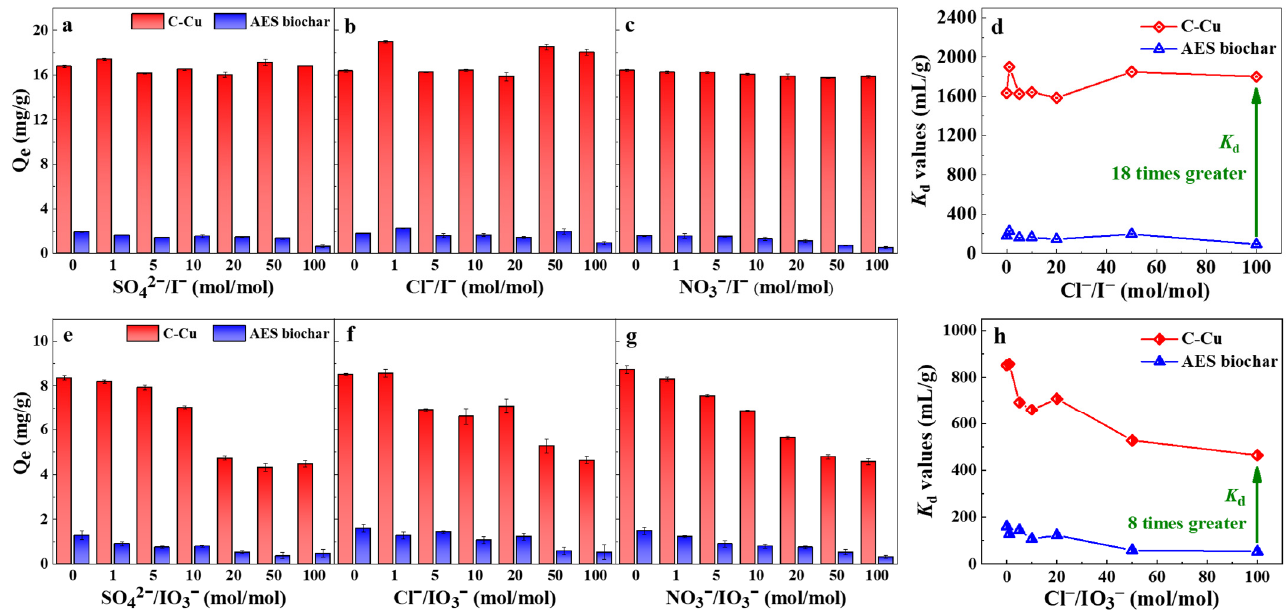
Figure 5. Effects of competitive ions on the removal of iodide and iodate anions: ( a – c ) I − adsorption against SO 42 − Cl − , and NO 3 − ; ( d ) K d value of I − against Cl − ; ( e – g ) IO 3 − adsorption against SO 42 − , Cl − , and NO 3 − ; ( h ) K d value of IO 3 − against Cl − ; adsorbents 0.5 g/L, 25 °C, pH = 7 ± 0.2.